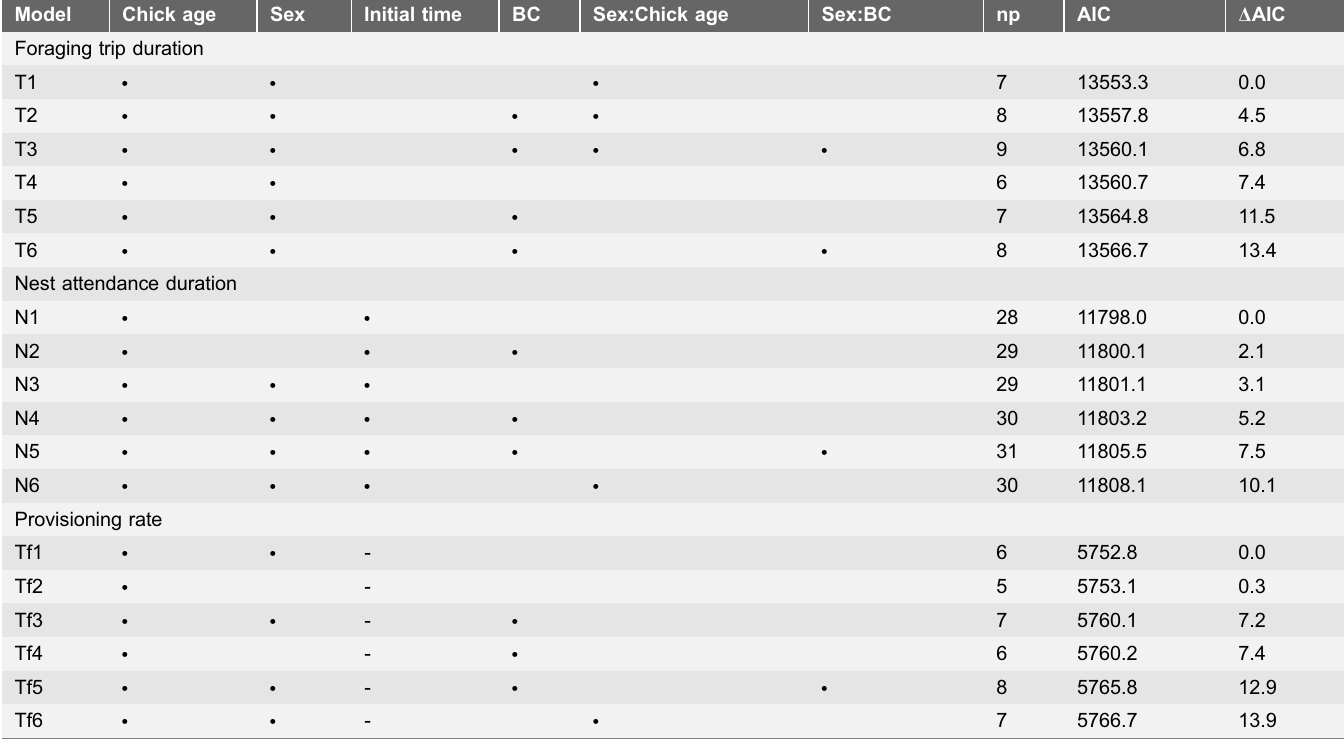
Table 1. Linear mixed-effects models of Cape gannet behavioural parameters.